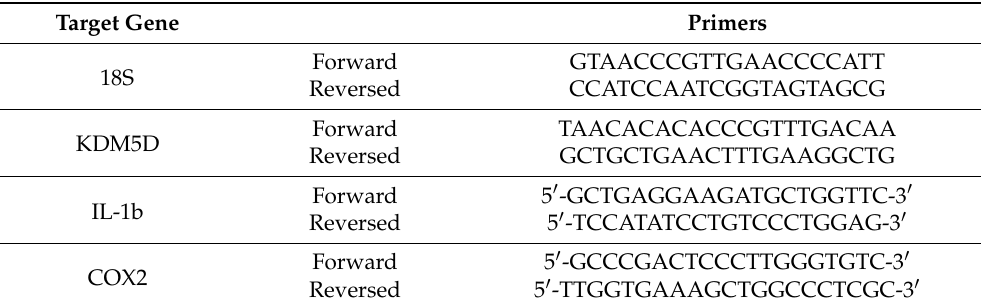
Table 1. Primers used for cell number analysis of chondrocytes and tSVF-derived cells co-cultures and in vitro inflammation